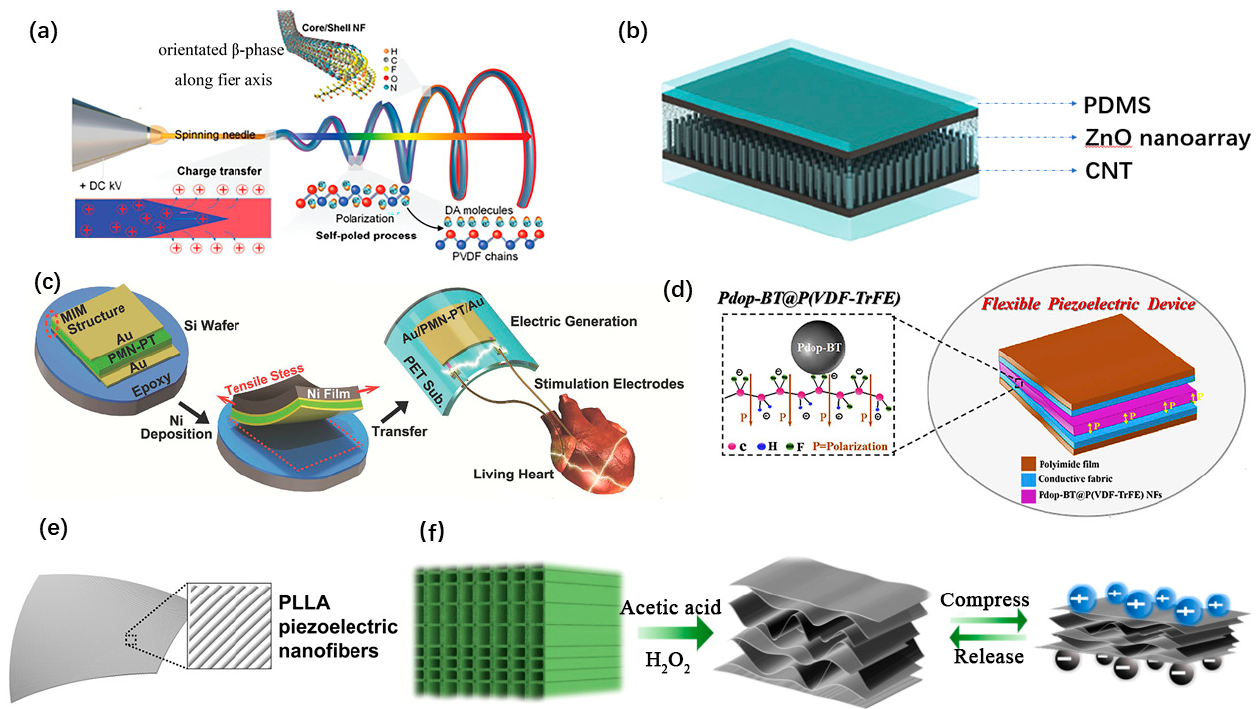
Figure 3. Materials of wearable and implantable PENGs. ( a ) A core/shell PVDF/dopamine nanofiber-based PENG. Repro-